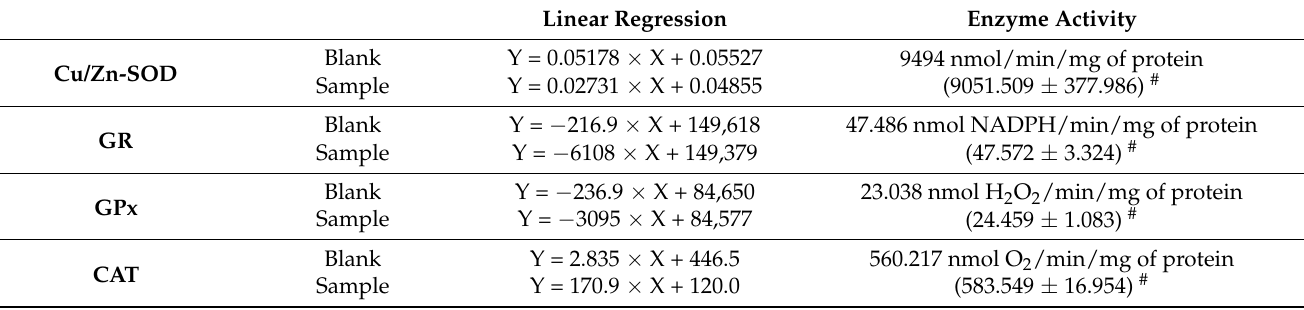
Table 11. Typical linear regressions of cytosolic antioxidant enzymes obtained in assays with 50 µ g of protein under “blank” and “sample” conditions (Figure 13) and the calculated enzyme activity. Linear Regression Enzyme